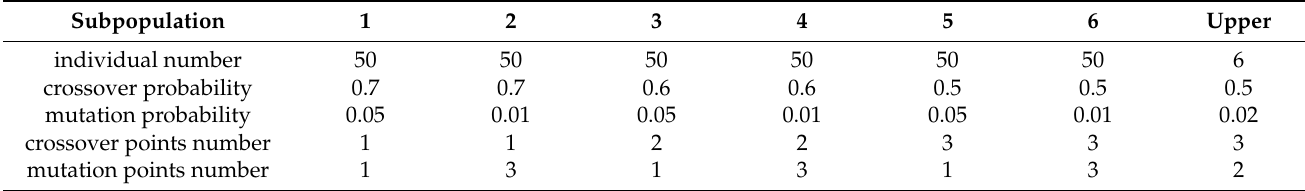
Table 3. The operation parameters used in proposed genetic algorithm.